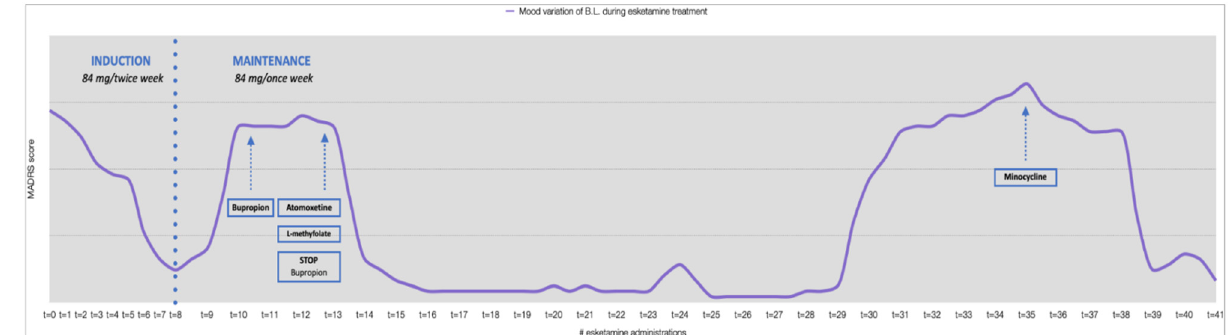
Figure 4. Mood variation and pharmacologic modulation during ESK treatment .